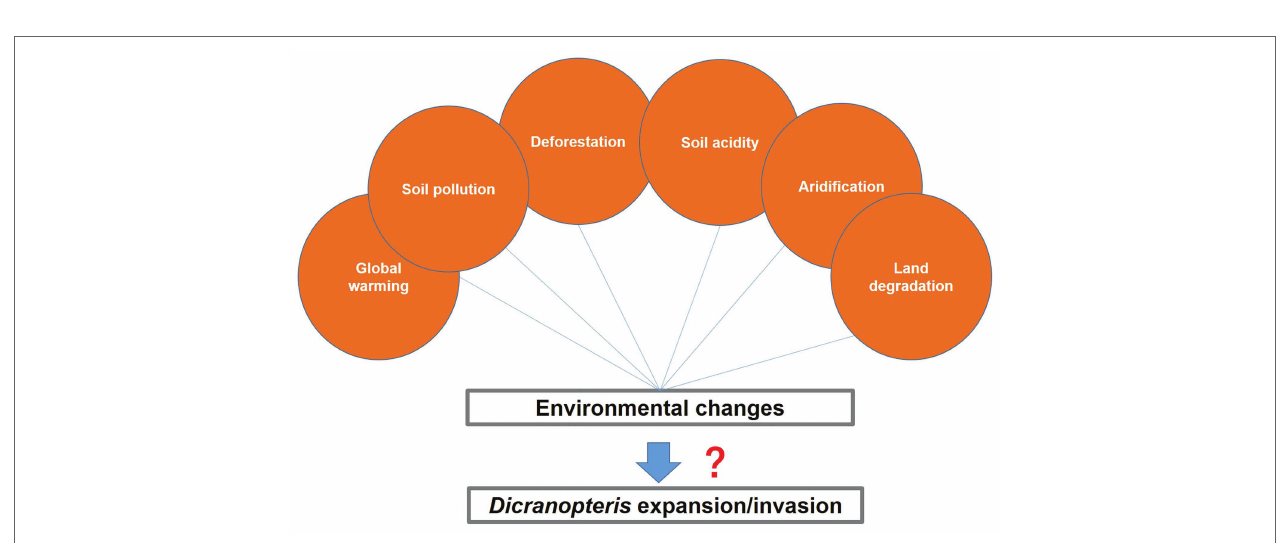
FIGURE 4 | The proposed ecological functions of Dicranopteris , including ecosystem recovery, resistance, and succession facilitation.